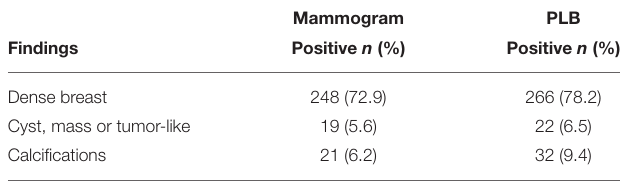
TABLE 2 | Mammogram findings reports compared to